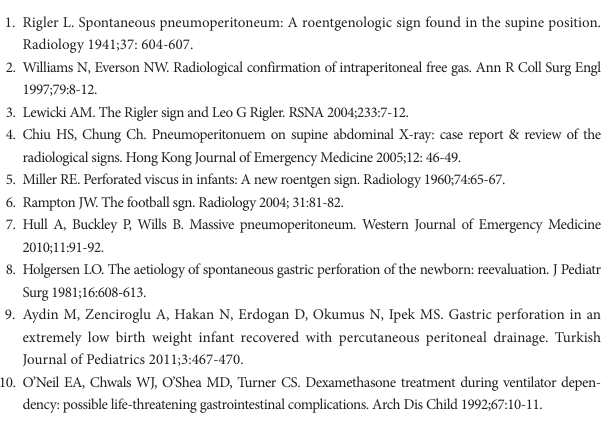
Fig. 1. (a) Supine abdominal radiograph demonstrating Rigler’s sign (closed arrows) and the football sign (arrow heads) in a patient with iatrogenic gastric perforation. Rigler’s sign is the visualisation of the inner and outer bowel wall owing to pneumoperitoneum, also known as the double-wall sign. The football sign is described as an oval radiolucency owing to pneumoperitoneum that resembles an American football. The vertical opacity of the falciform ligament (open arrow) represents the laces, and the remaining abdomen represents the reaming portion of an American football. (b) The lateral decubitus view confirms the pneumoperitoneum. Note Rigler’s sign (closed